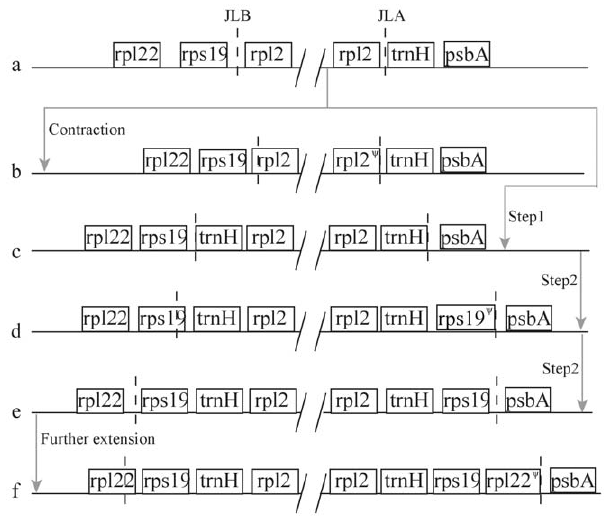
Figure 3. Expansion of IR into the LSC region. The dashed lines depict the junction boundaries. The arrowed grey lines indicate the process of IR expansions. a, Amborella and Nicotiana ; b, Lemna ; c, intermediate; d, Acorus and Dioscorea ; e, date palm, typha, and all Poaceaes; f, Phalaenopsis and Oncidium .